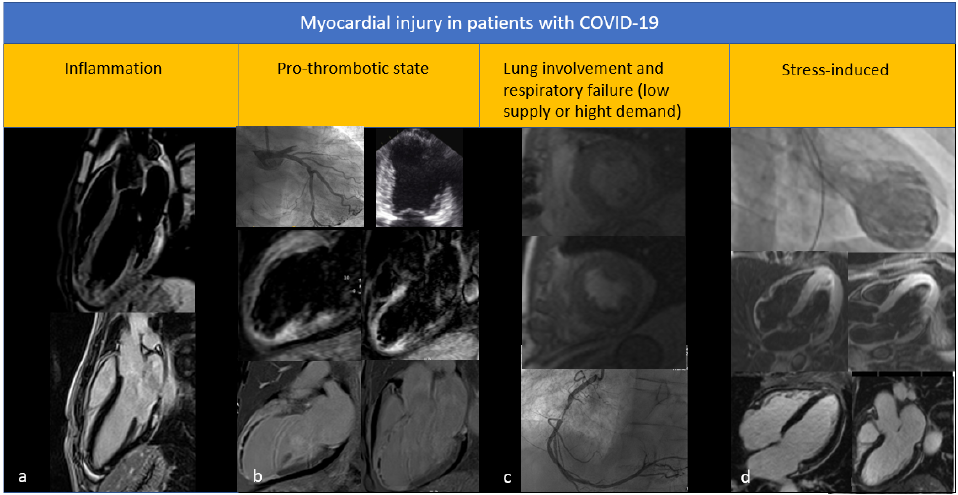
Figure 1. Myocardial injury in patients with COVID-19. ( a ) Case of myocarditis: CMR shows edema and fibrosis in the basal and apical infero-lateral wall of the left ventricle; ( b ) Case of myocardial infarction: coronary angiography shows occlusion of the anterior descending coronary artery; on echocardiography, alterations of the kinetics in the territory of the anterior descending coronary artery are noted and on CMR extensive areas of edema and fibrosis are described in the same location, with outcomes of microvascular damage; ( c ) Case of myocardial ischemia induced by hypoxia: stress CMR post-admission shows ischemia in the right coronary artery region, which will present a critical stenosis on coronary angiography; ( d ) Case of Tako-tsubo: ventriculography shows the typical apical ballooning appearance of the left ventricle; CMR confirms the presence of edema and the absence of fibrosis in the apical area.